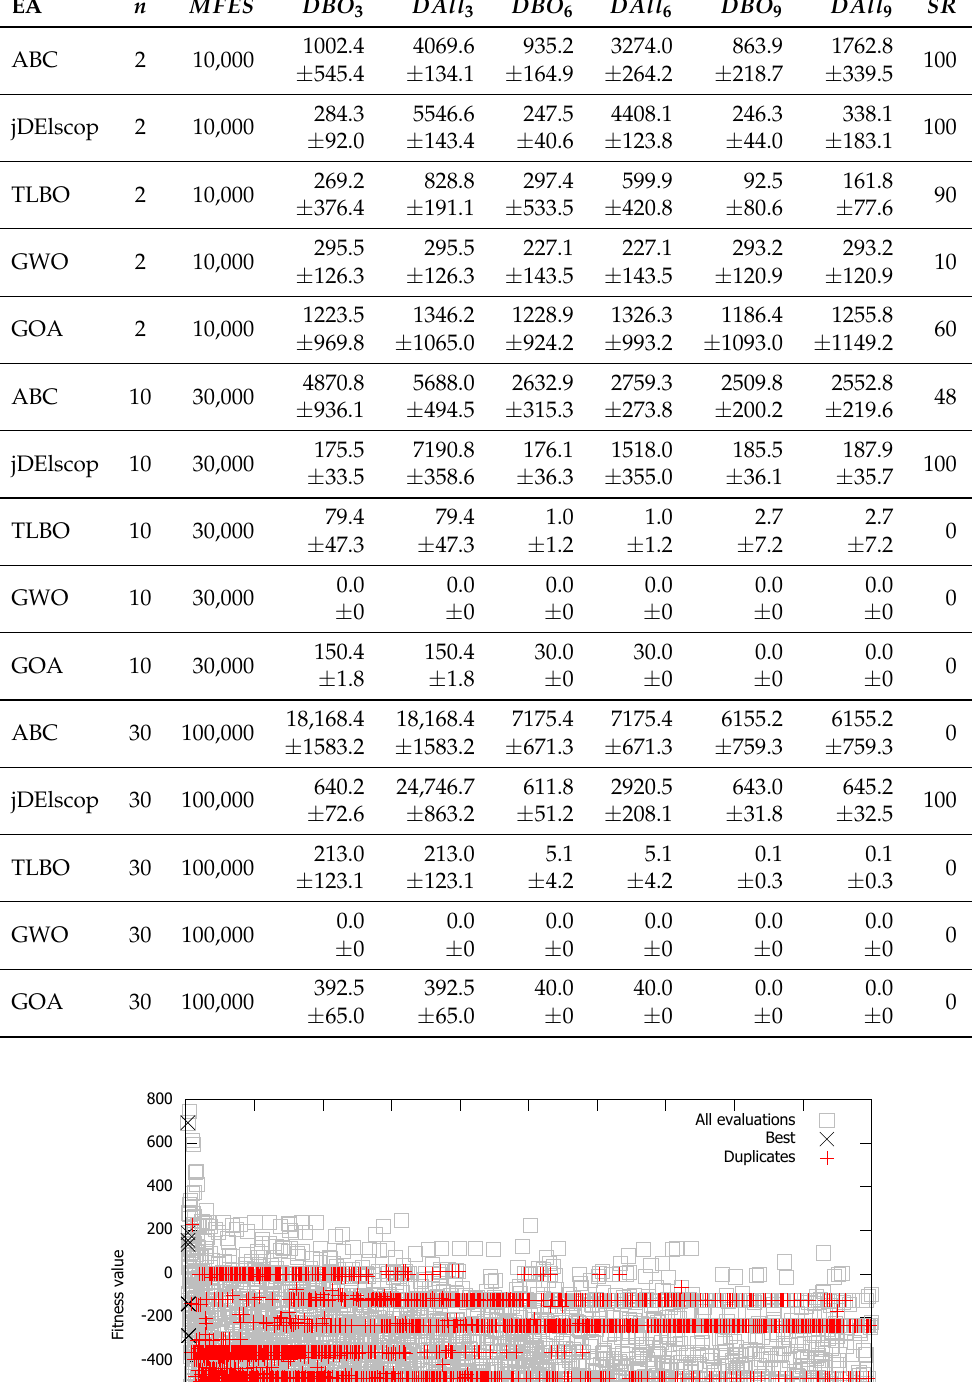
Table 6. Number of duplicate individuals’ evaluation for the Schwefel 2.26 problem.